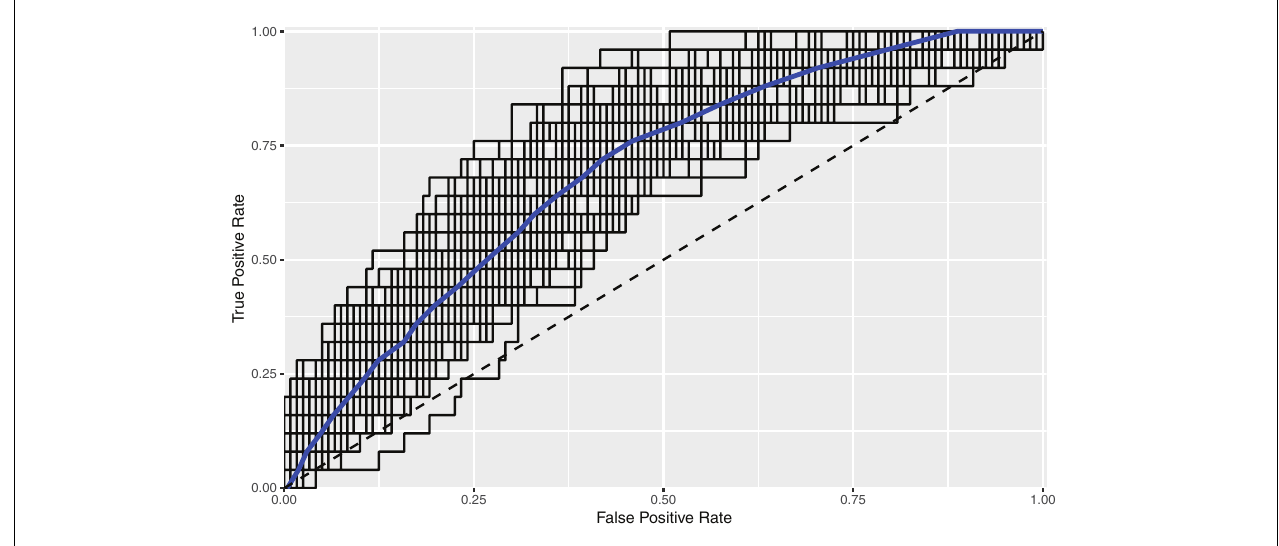
FIGURE 4 | Receiver operating characteristic curves illustrating predictive performance of the Glmnet machine learning method for the RFE NCRA + Demographics feature set.